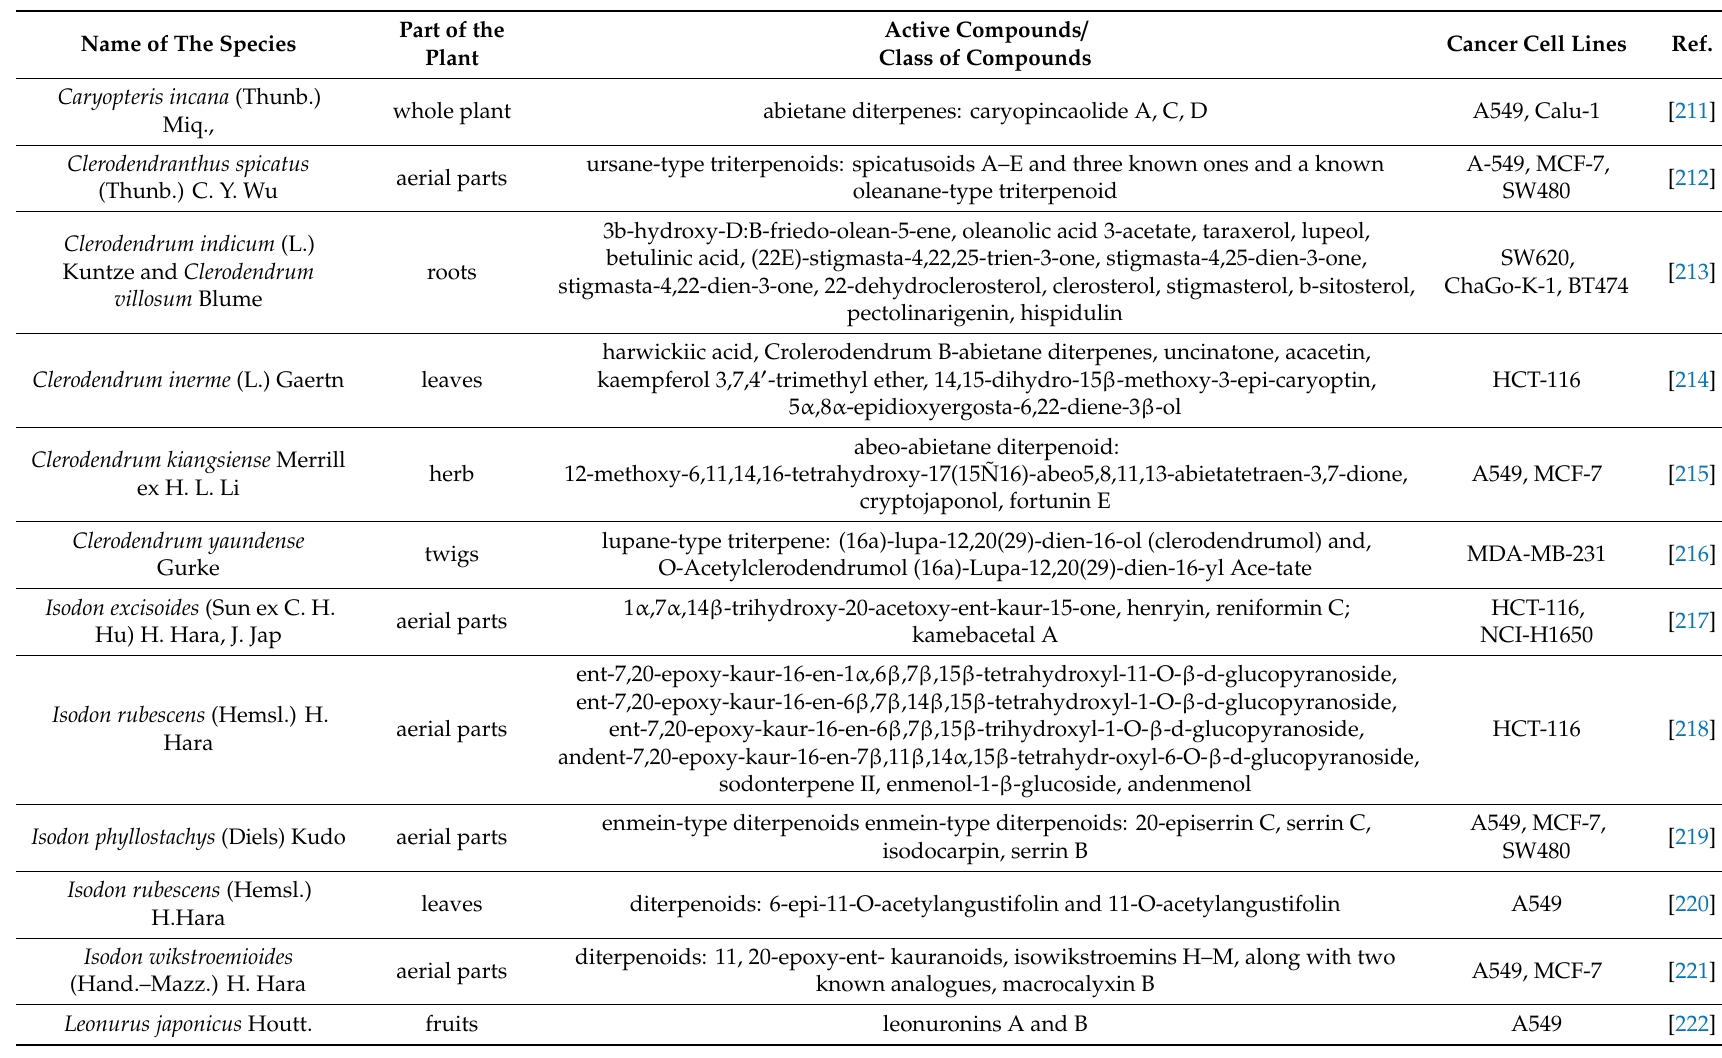
Table 2. Cytotoxic properties of isolated pure compounds from the Lamiaceae family against lung, colon, breast, and prostate cancer